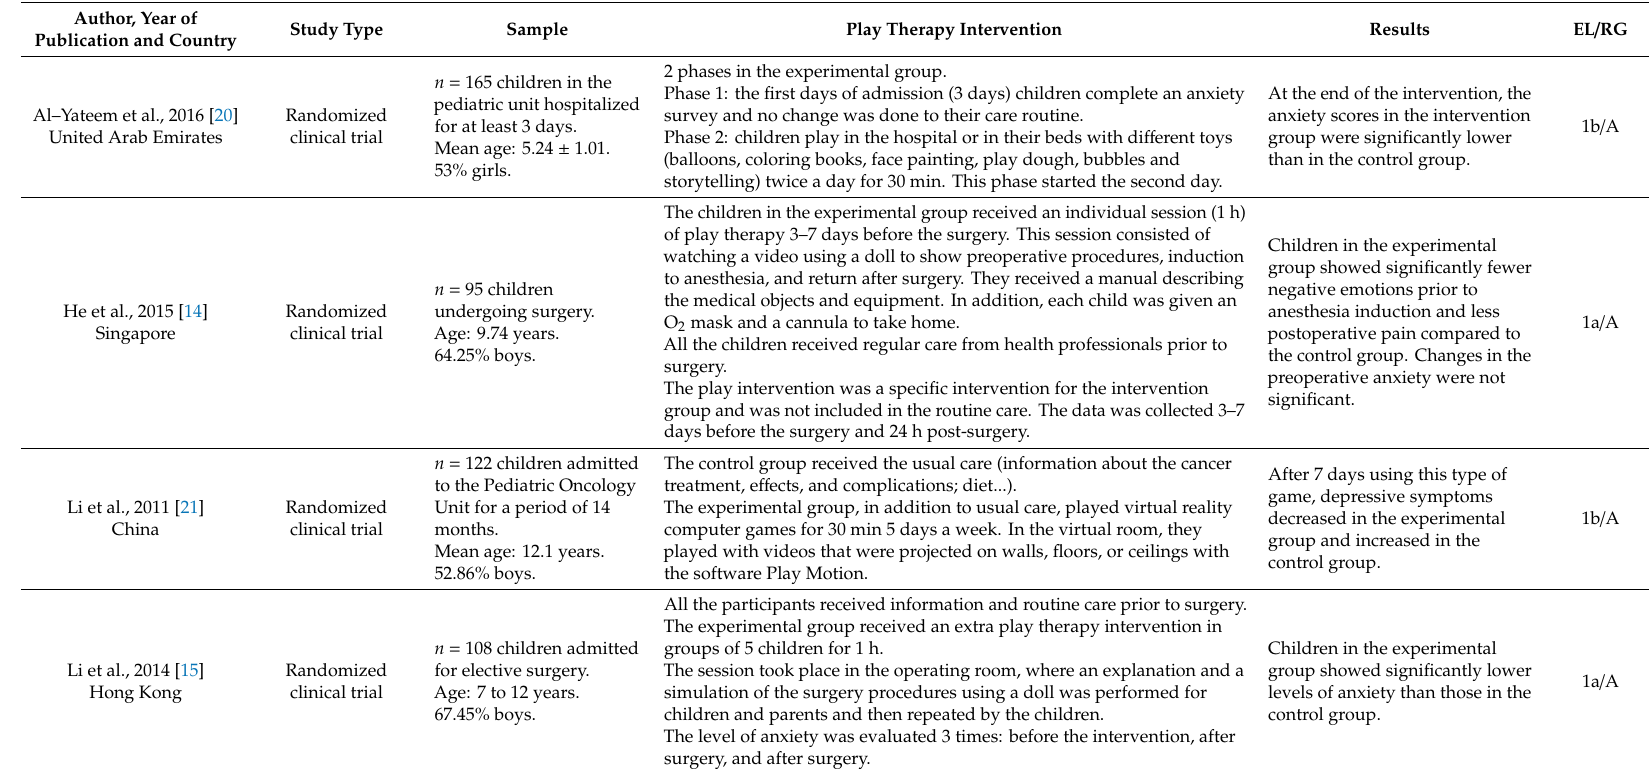
Table 1. Summary of the included studies ( n =